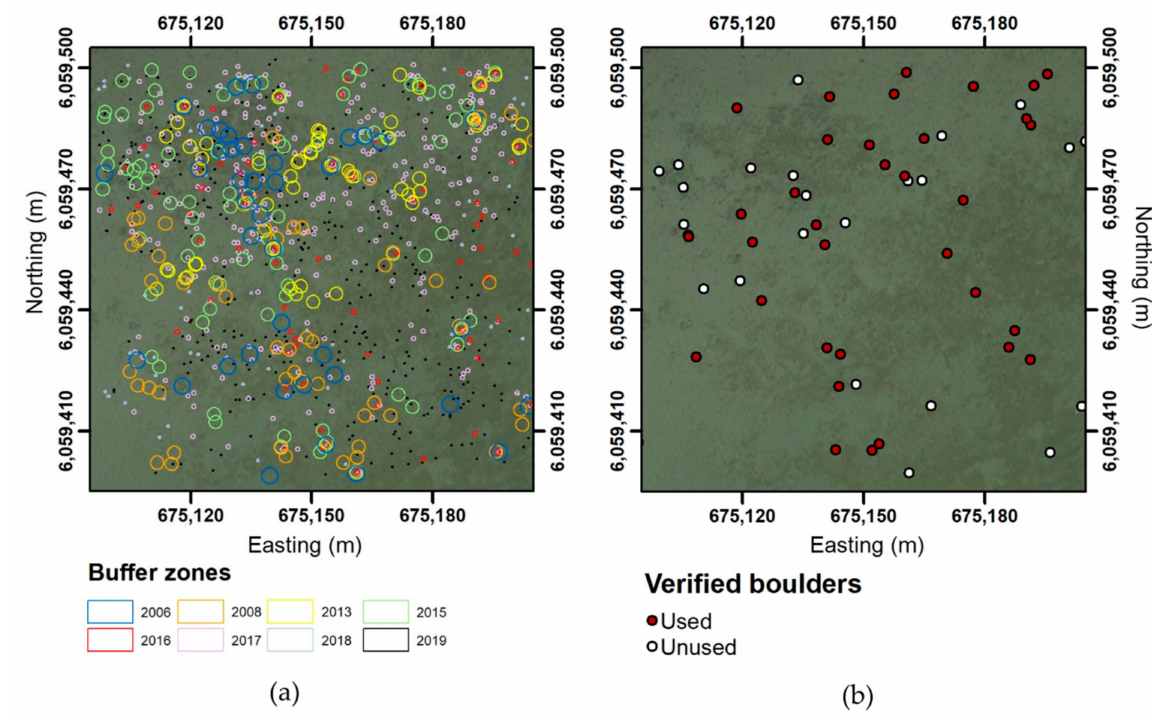
Figure 6. ( a ) Potential boulders from orthophoto mapping with buffer zones. ( b ) Boulders found from three overlapping buffer zones. Red dots are boulders used for machine learning and white dots are boulders that were not used for machine learning. Projection is in ETRS89 UTM Zone 32N with units in